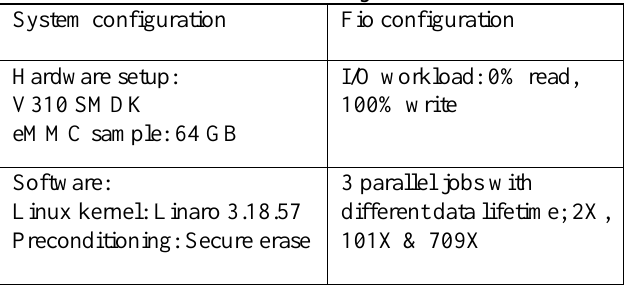
Table 1. Benchmarking Environment